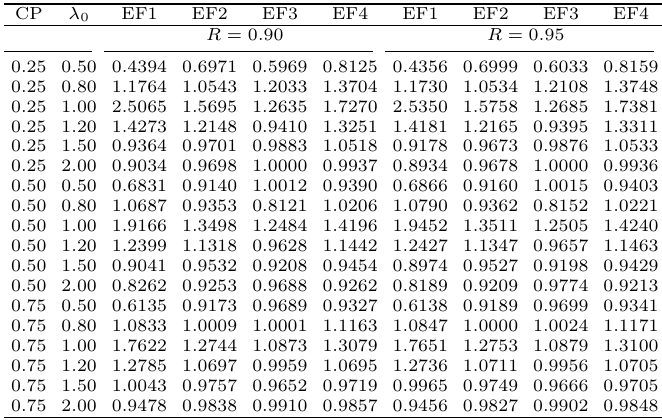
Relative efficiencies of the estimators for R ( t ) under Type II